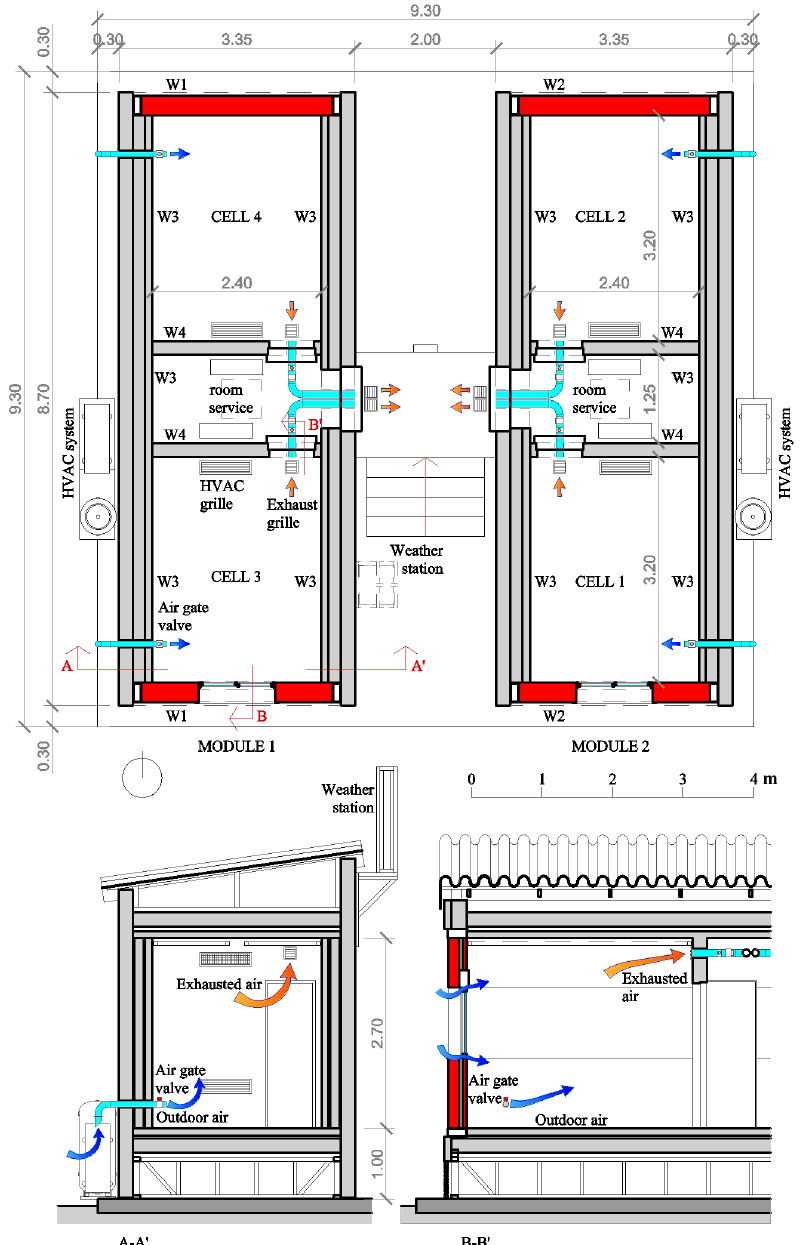
Figure 3. Floor plans and cross-sections showing the spatial organization of the test cells. Dimensions are in metres.